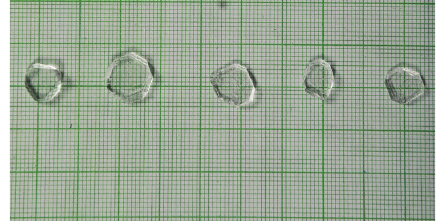
Figure 1: Photograph of as-grown SA single crystals.